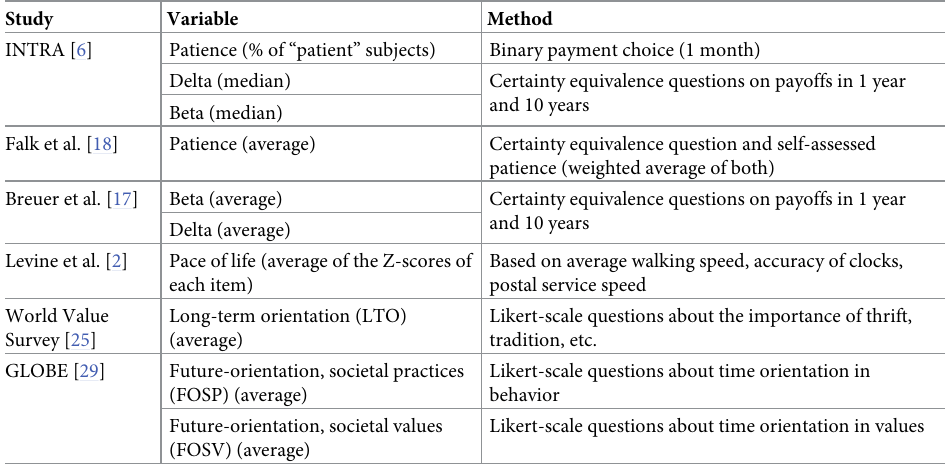
Table 1. Overview of the international studies on time